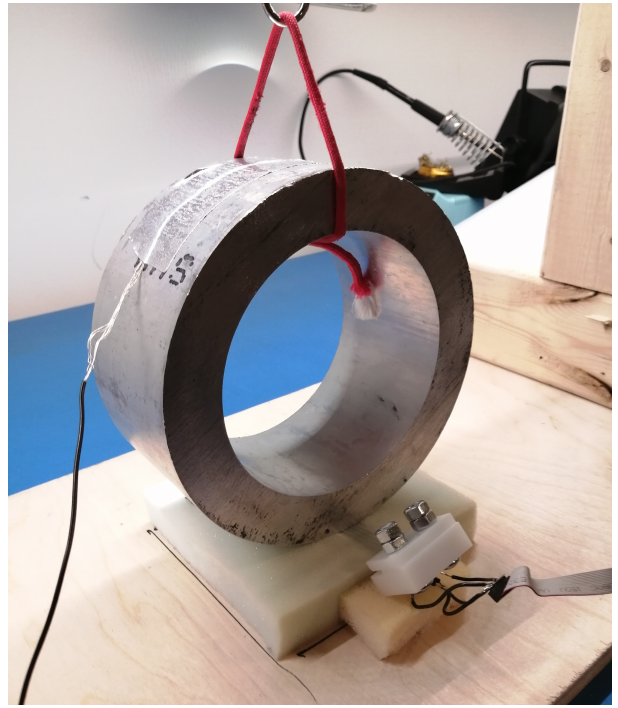
Figure 6. Setup for pass-band gain and cut-off frequency acquisition.